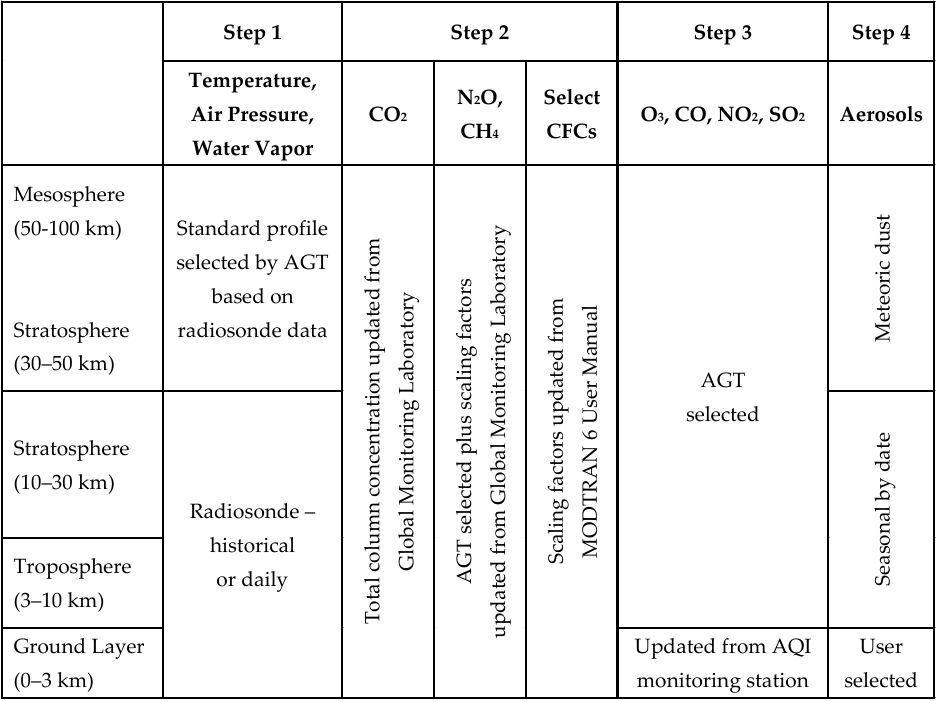
Figure 3. Custom atmosphere workflow overview.